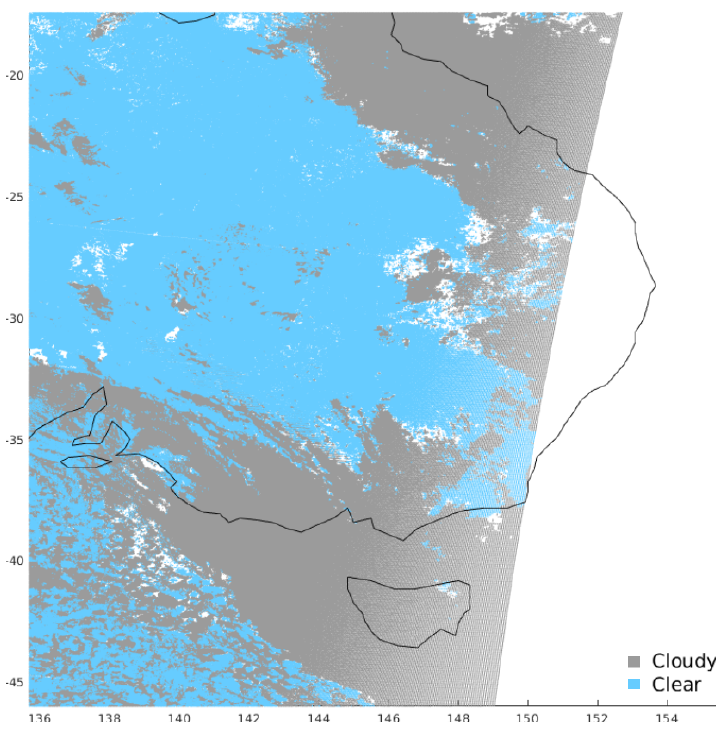
Figure 3. Example of MODIS cloud mask co-located to PROBA-V image PROBAV_L2A_20140321_000512_3_333M_V001 over South